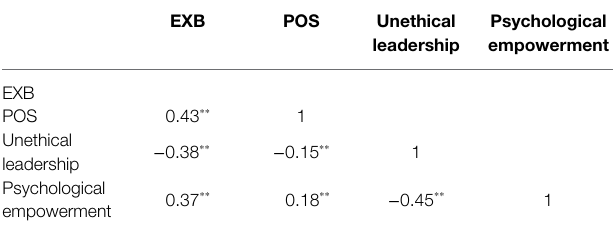
TABLE 2 | Correlation matrix.